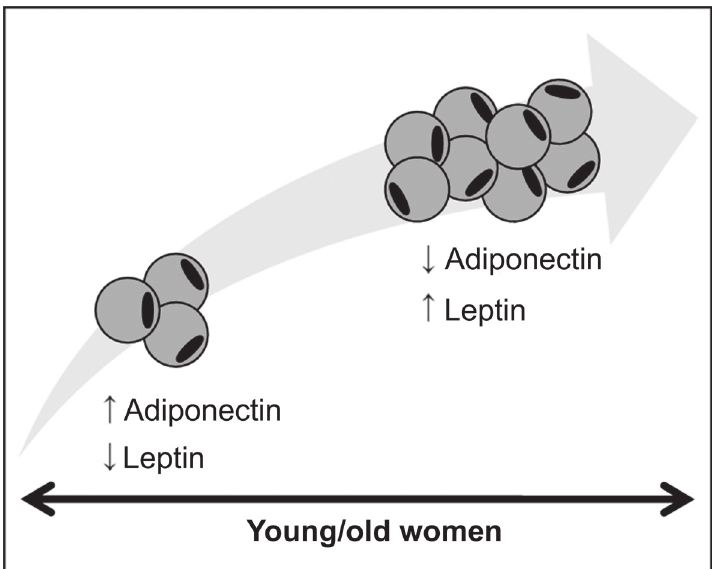
Figure 3. Serum levels of leptin and adiponectin in different phases of the female life course. Serum adiponectin concentrations decrease, while serum leptin lev- els markedly increase with